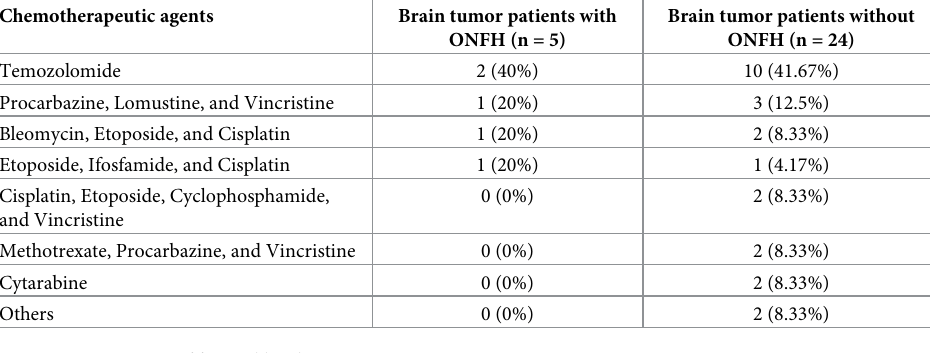
Table 3. Chemotherapeutic agents in brain tumor patients with adjuvant